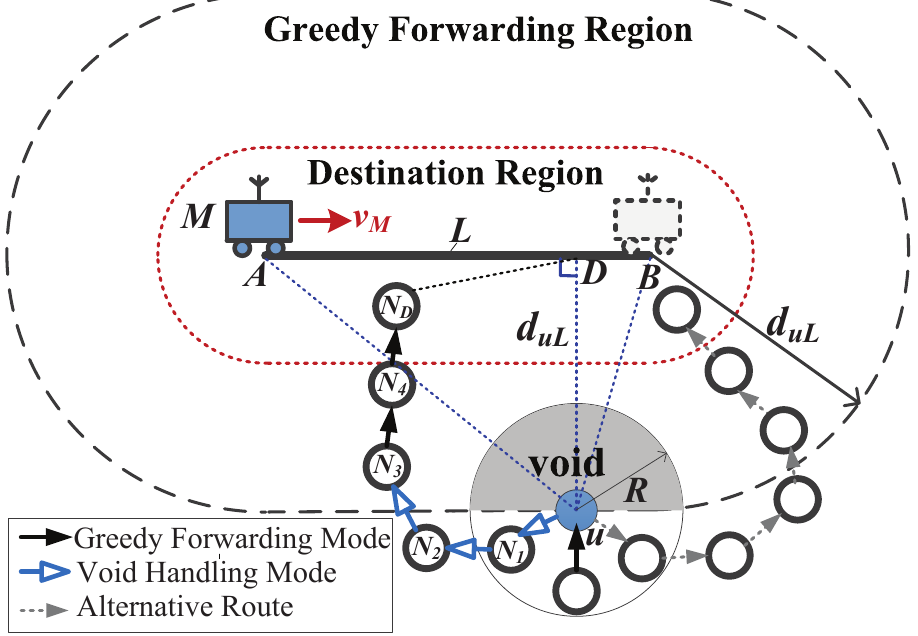
Figure 4. An example of void handling for